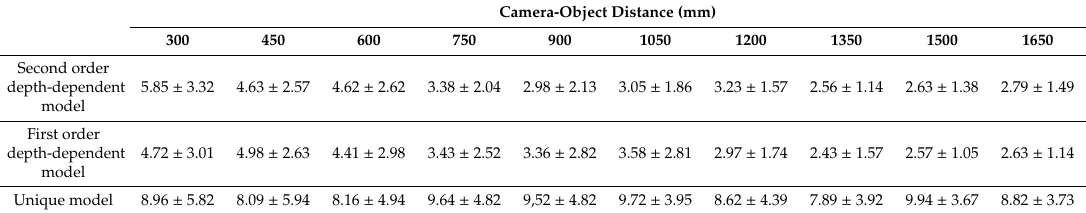
Table 2. Calibration error with 12-mm lens and parallel planes (mean and standard deviation) a .